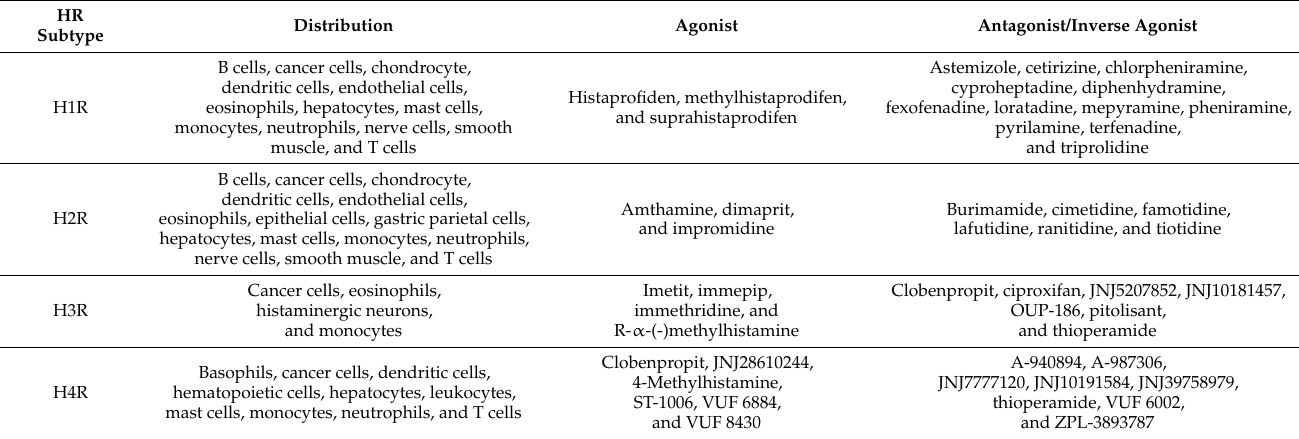
Table 1. Distribution of HR subtypes and their specific agonists and antagonists [9,11,22–24,27,28,30,32–37]. HR